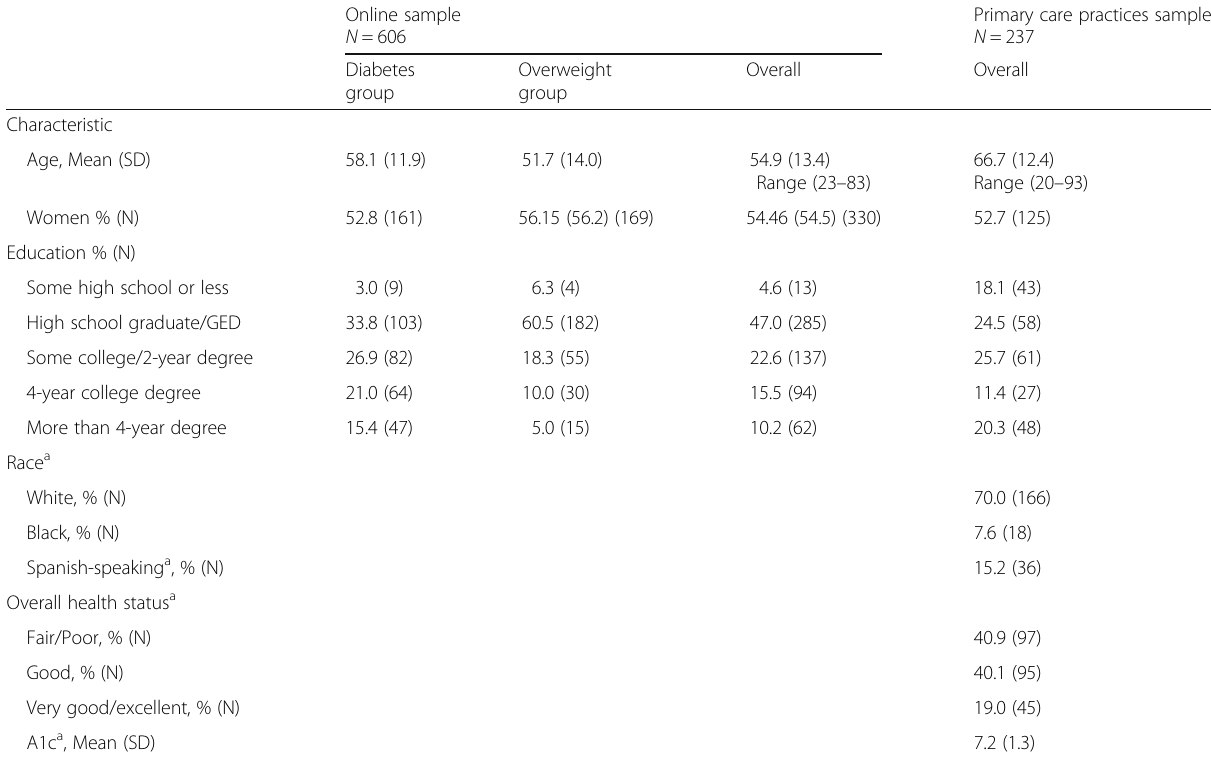
Table 2 Patient characteristics for the online and primary care practices